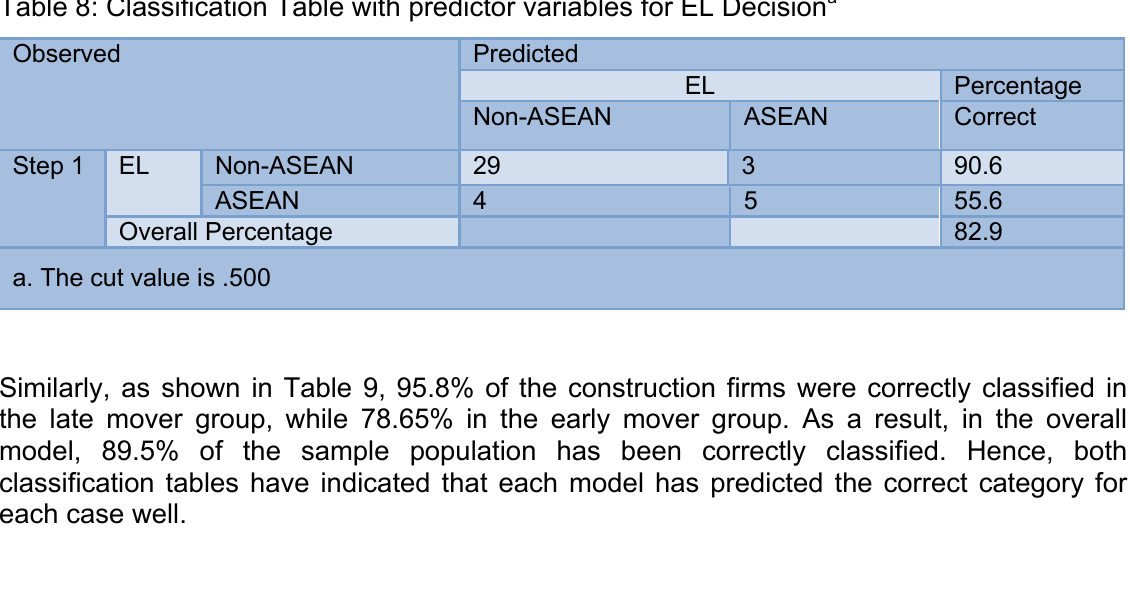
Table 8: Classification Table with predictor variables for EL Decision